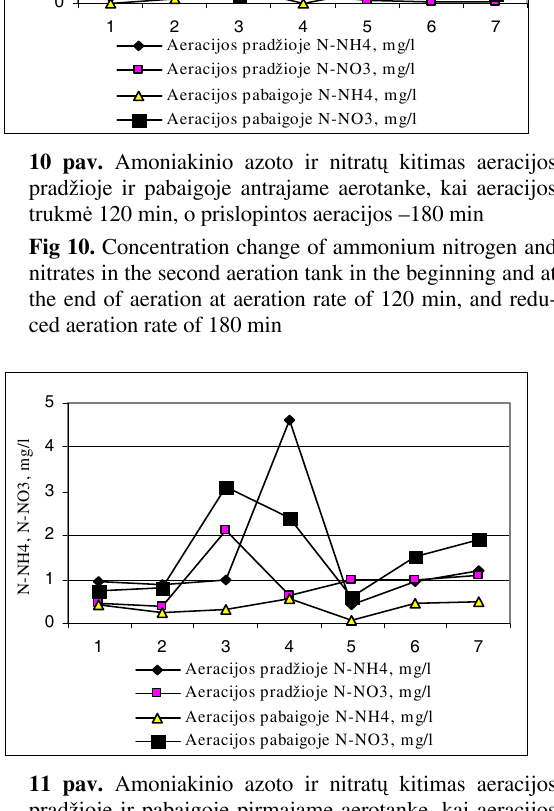
Fig 11. Concentration change of ammonium nitrogen and nitrates in the first aeration tank in the beginning and at the end of aeration at aeration rate of 150 min, and redu- ced aeration rate of 180 min